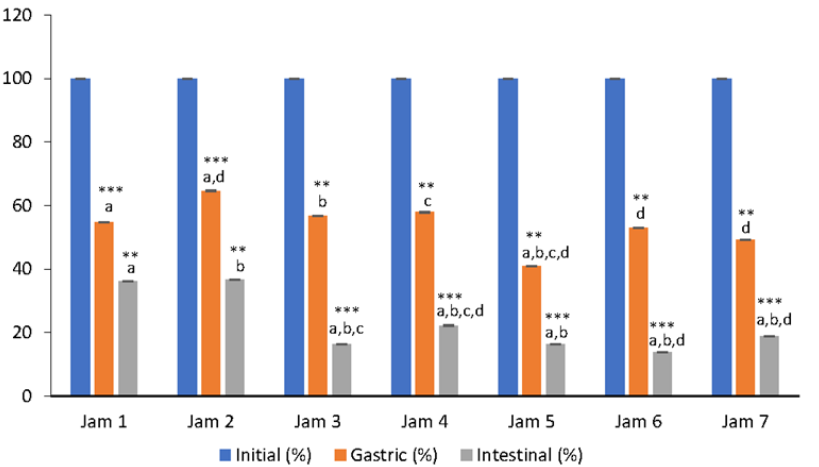
Figure 2. Changes in bioaccessibility(%) of total anthocyanins during in vitro simulated digestion of lingonberry jams. Data represent average values ± standard deviation of three independent measurements and initial bioaccessibility determined in non-digested jams is set as 100%. Letters a,b,c,d indicate statistically significant differences between the values for each phase of digestion ( p < 0.05) according to Student’s t tests. Asterisk symbols signify the following levels of statistical significance of differences according to one way ANOVA and Student’s t tests: *** p < 0.0001, ** p < 0.001.